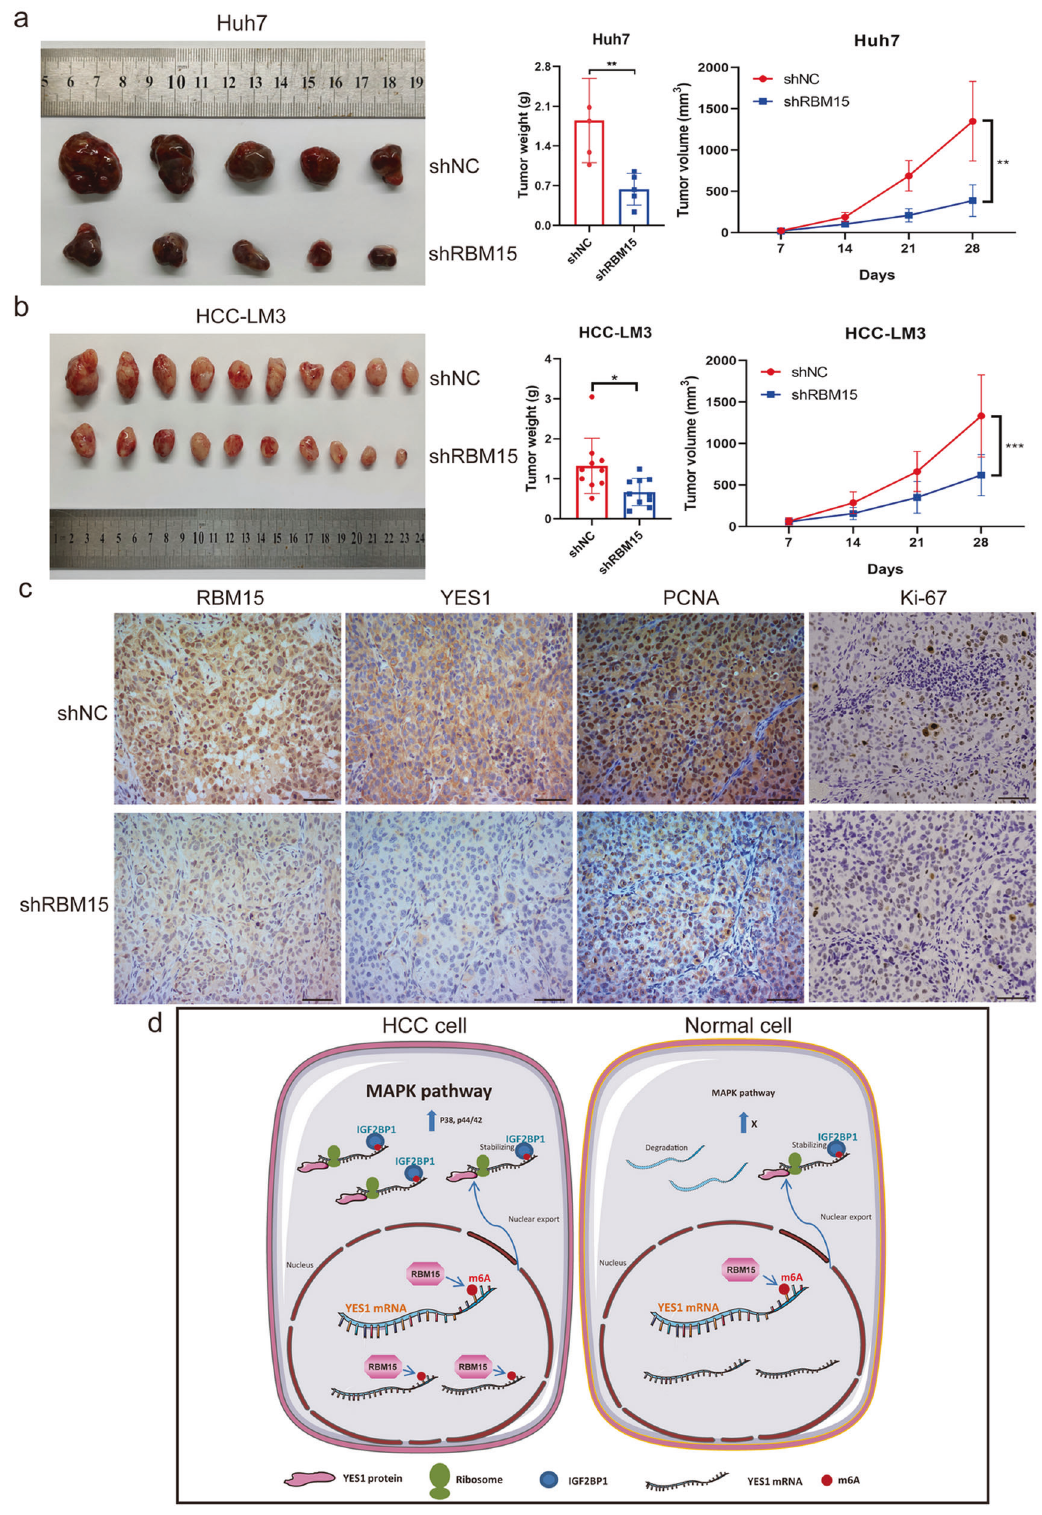
Fig. 8 RBM15 promotes tumor growth of HCC cells in vivo. a , b Tumor xenograft models were constructed with stable RMB15-knockdown Huh7 cells ( n = 5) and HCC-LM3 cells ( n = 10). Tumor sizes were recorded per week consecutively to plot tumor growth curves. After collecting tumors from sacri fi ced mice, tumor weights were measured and compared between shRBM15 and shNC cells (* p < 0.05, ** p < 0.01, *** p < 0.001; two-way ANOVA and t test); c representative IHC staining images of xenograft tumors. Knockdown of RBM15 decreased the expression of YES1, PCNA, and Ki-67 (scale bars, 200 μ m); the data are presented as mean ± SD; d abstract graph illustrated our fi ndings on RBM15- mediated m 6 A regulation. The data are presented as mean ± SD.